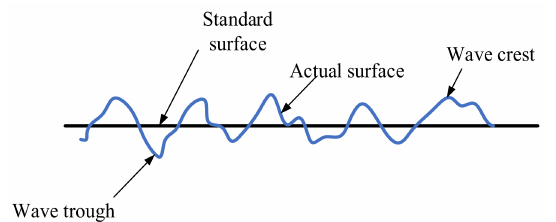
Figure 1. Surface roughness waveform.